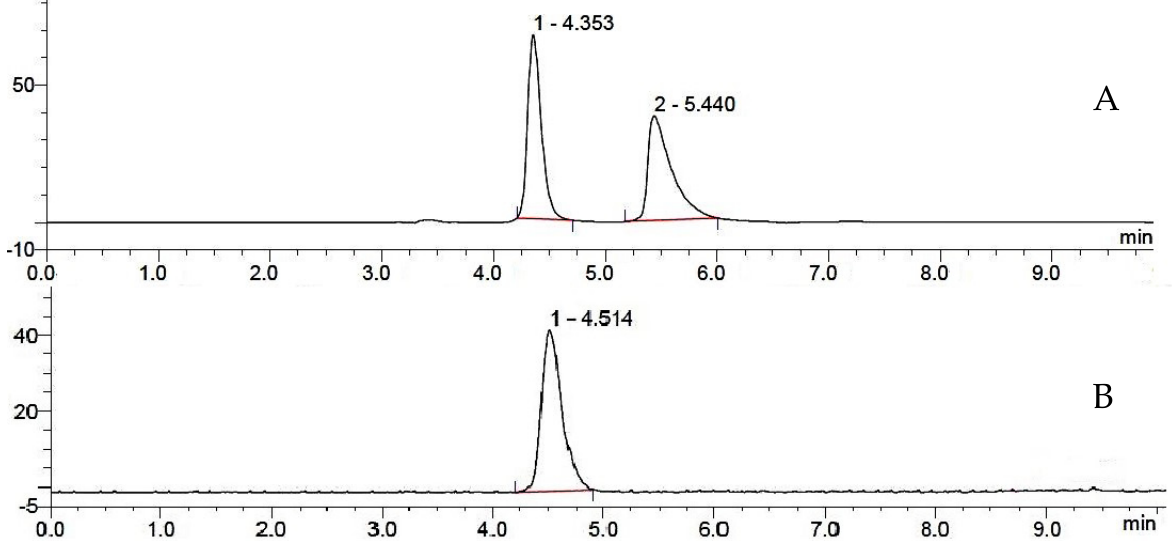
Figure 4. Determination of enantiomeric purity of 6- L -[ 18 F]FMT by chiral HPLC: ( A ) 6- DL -FMT, UV trace ( λ = 254 nm); peak 1 - 6- L -FMT; peak 2 - 6- D -FMT; ( B ) 6-L-[ 18 F]FMT, radioactivity trace. HPLC conditions: column Chirobiotic T 150 × 4.6 mm (Astec, USA); eluent: 10% EtOH in 0.1% Et 3 NOAc; flow rate: 1.0 mL/min.